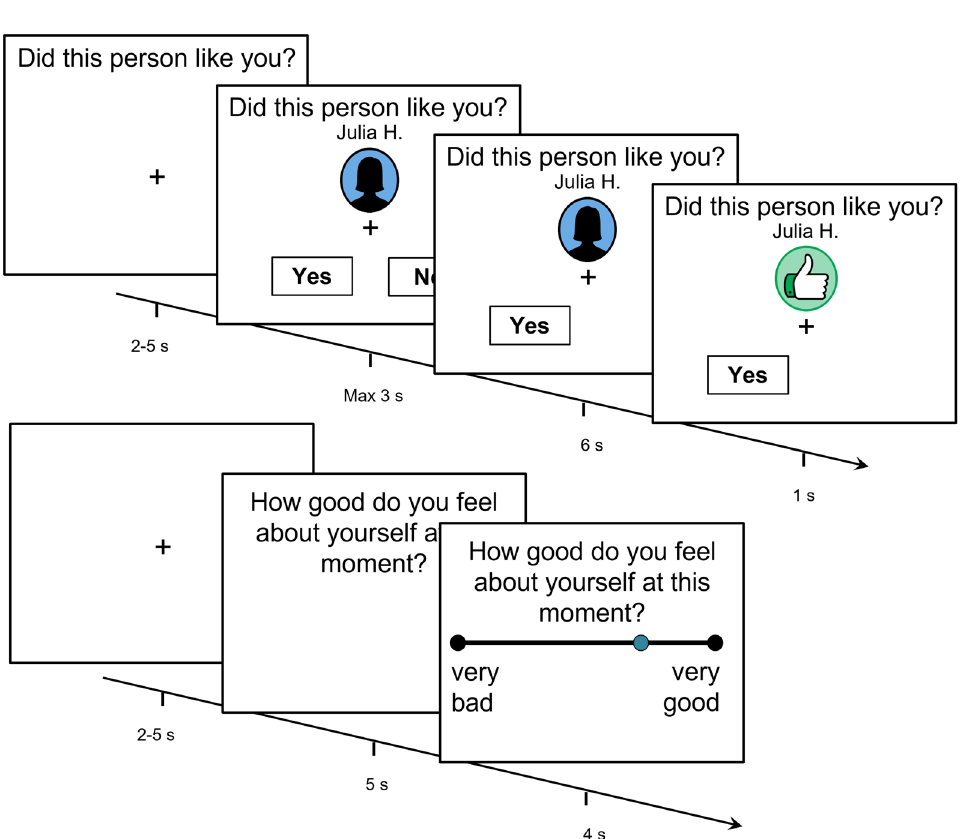
Figure 1. Trial structure of the task, reproduced with permission from Will et al. 6 . Participants were asked to predict whether another person liked them or not based on a cue indicating how approving a rater was in general toward other people. After the outcome become known, their self-esteem was probed by asking participants how good they felt about themselves. Please see “Methods” for detailed